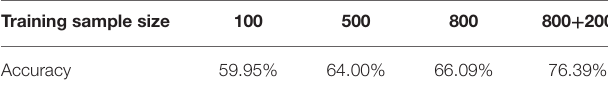
TABLE 4 | Accuracy of poker pattern recognition.